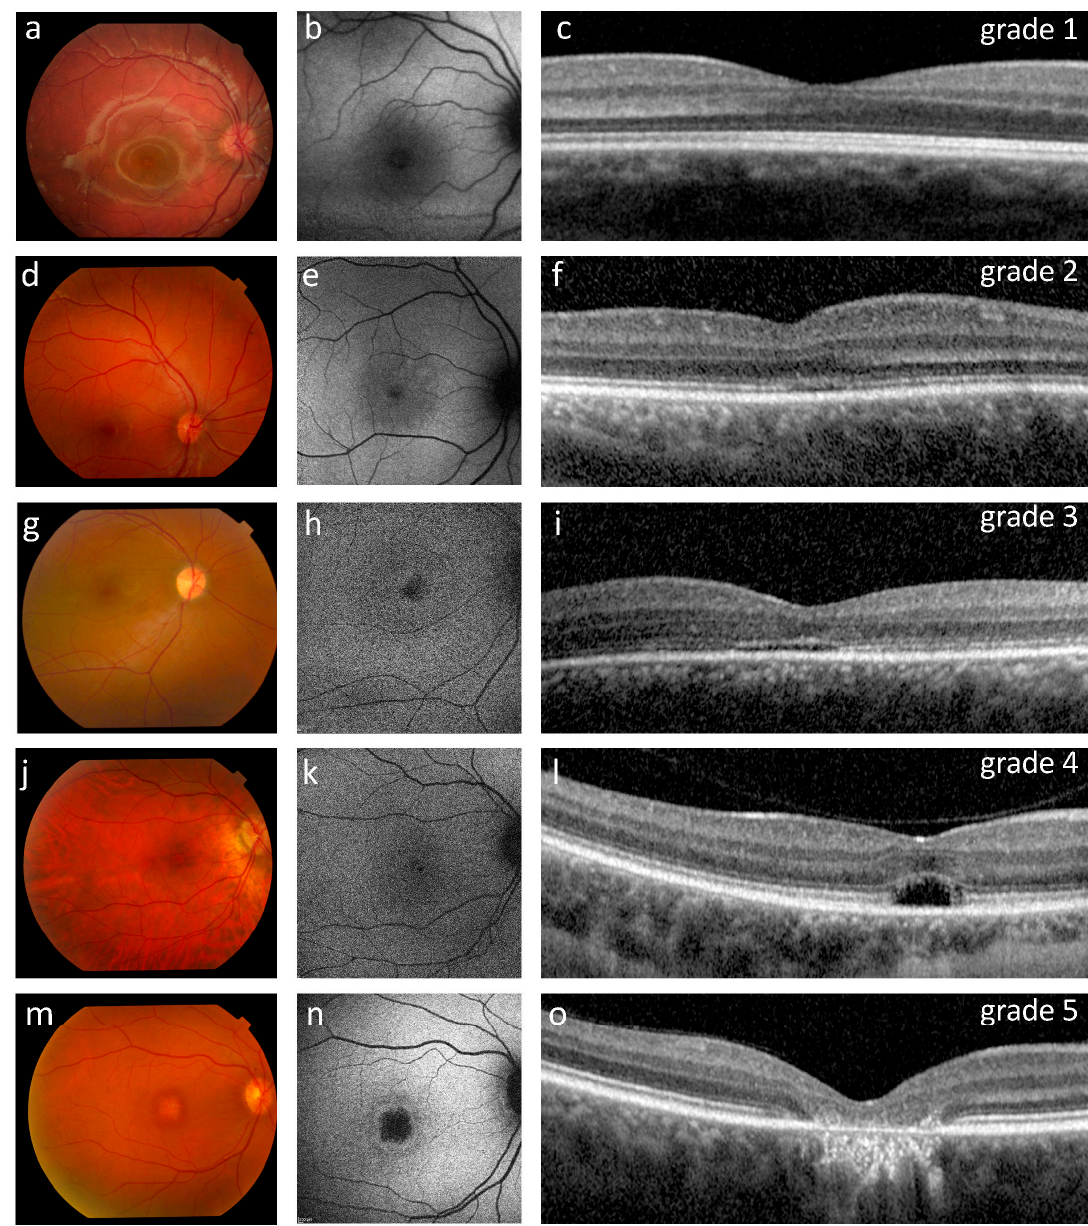
Figure 2. Ophthalmological findings in five representative ACHM patients showing the OCT grading ( c , f , i , l , o ) with cor- responding retinography ( a , d , g , j , m ) and fundus AF images ( b , e , h , k , n ). ( a – c ) Patient P15 (12 years old, homozygous